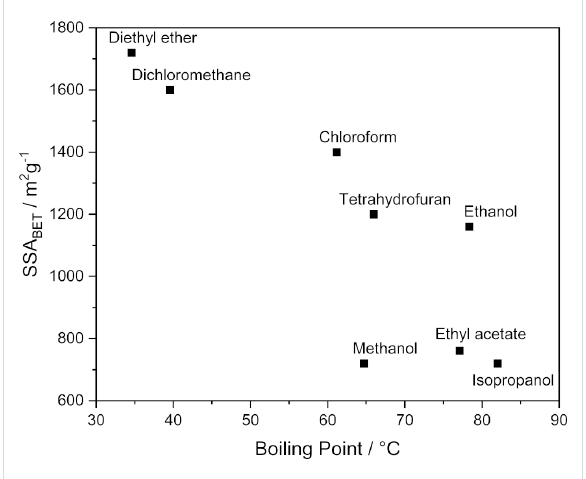
Figure 4: The correlation between the liquids’ boiling point and the SSA of the polymer. In general, a lower boiling point of the LAG addi- tive leads to a higher